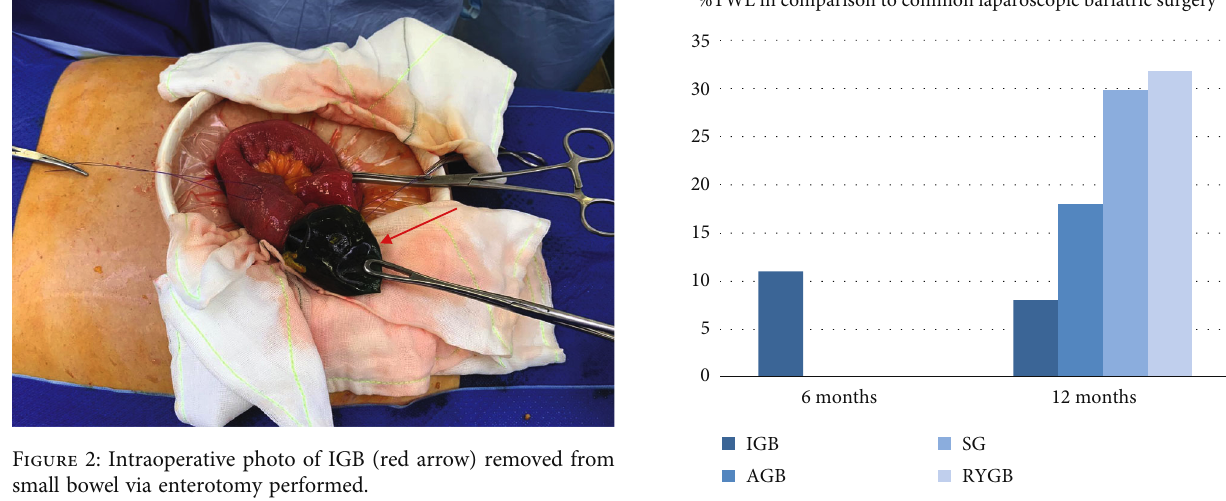
Figure 3: Comparison of weight loss e ffi cacy (% total body weight loss) between IGB and common laparoscopic bariatric surgery at 6 and 12 months [7, 10, 11]. IGB: intragastric balloon; ABG: adjustable gastric band; SG: sleeve gastrectomy; RYGB: Roux-en- Y gastric